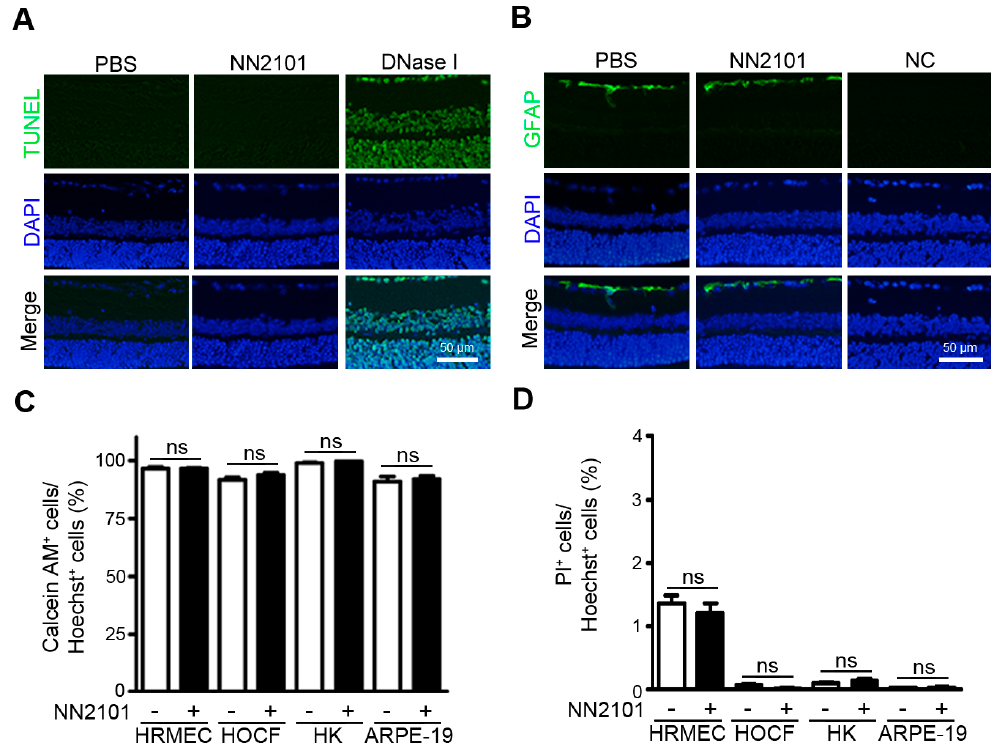
Figure 4. NN2101 does not induce ocular toxicity. ( A , B ) an intravitreal injection of NN2101 induces no ocular toxicity in normal adult mice. Mice received a single intravitreal injection of NN2101 (20 μ g in 1 μ L) or an equivalent volume of PBS. Eyes were harvested two weeks after injection. TUNEL assay ( A ) and immunofluorescence staining with anti-GFAP IgG ( B ) were performed on paraffin sections of the whole eyes. In the TUNEL assay, DNase I-treated sections were included as positive controls. In the immunofluorescence staining with anti-GFAP IgG, sections stained with irrelevant nonspecific IgGs were included as negative controls (NC). The nuclei are shown in blue (DAPI). Representative images in ( A , B ) were selected from three independent experiments with similar results. All scale bars = 50 μ m. ( C , D ) NN2101 induces no cytotoxicity in human ocular cells. HRMECs, HOCF, HK, and APRE-19 cells were incubated with NN2101 (400 μ g/mL) or PBS for 3 days, and the percentages of calcein-AM-positive live cells ( C ) and PI-positive dead cells ( D ) were assessed. The data are shown as the mean ± SEM (unpaired Student’s t -test, ns = not significant, n = 6).